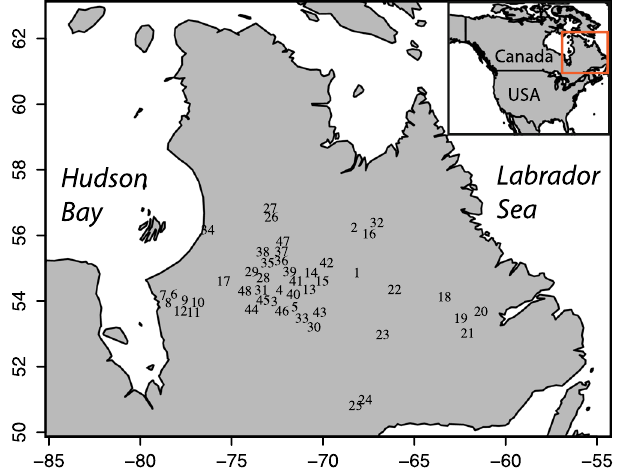
Figure 1. Tree ring sampling sites in Eastern Canada (EC). Map generated in R 63